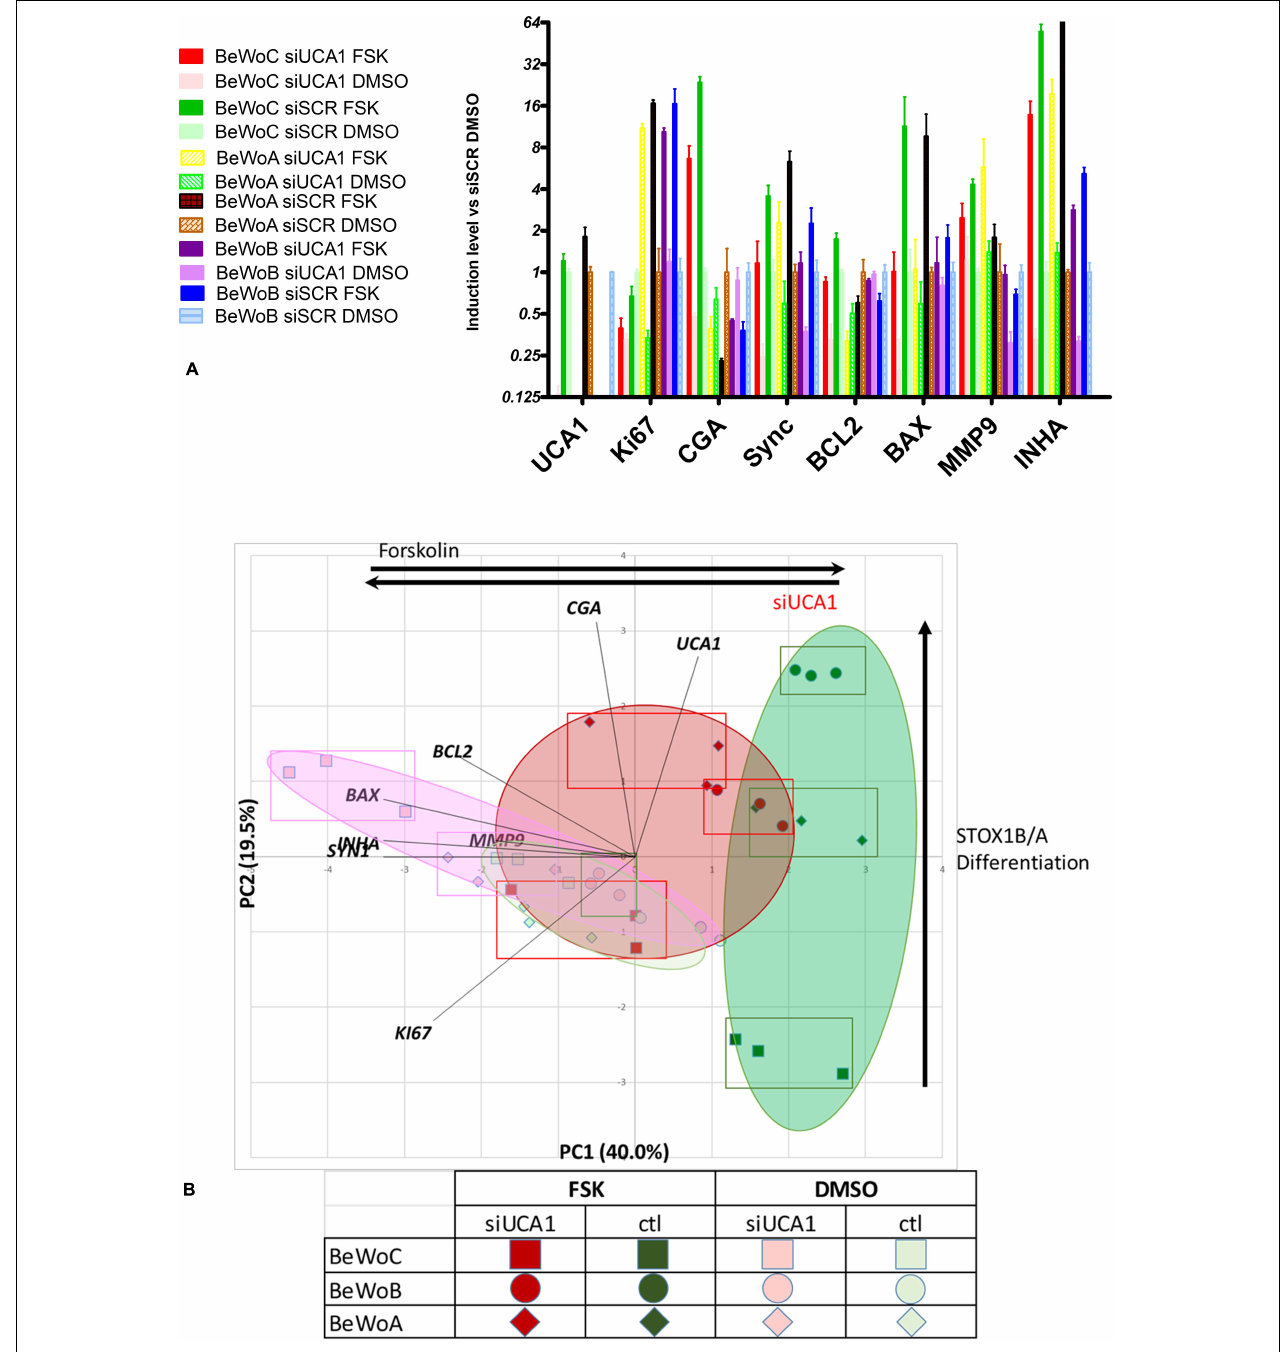
FIGURE 8 | (A) qRT-PCR analysis of the efficiency of UCA1 silencing in controls BeWoC and BeWo overexpressing either STOX1A or STOX1B, with or without forskolin treatment, and its effects on several markers of syncytialization. (B) Principal Component Analysis of the BeWo cells [controls BeWoC (circles) and overexpressing either STOX1A (lozenges) or STOX1B (circles)]. The genes are represented in black bold characters. The rectangles show the position of the different replicates. Red color marks UCA1 KD, while green are control cases. Dark colors mark FSK treatment. The interpretation of the axes is marked by black